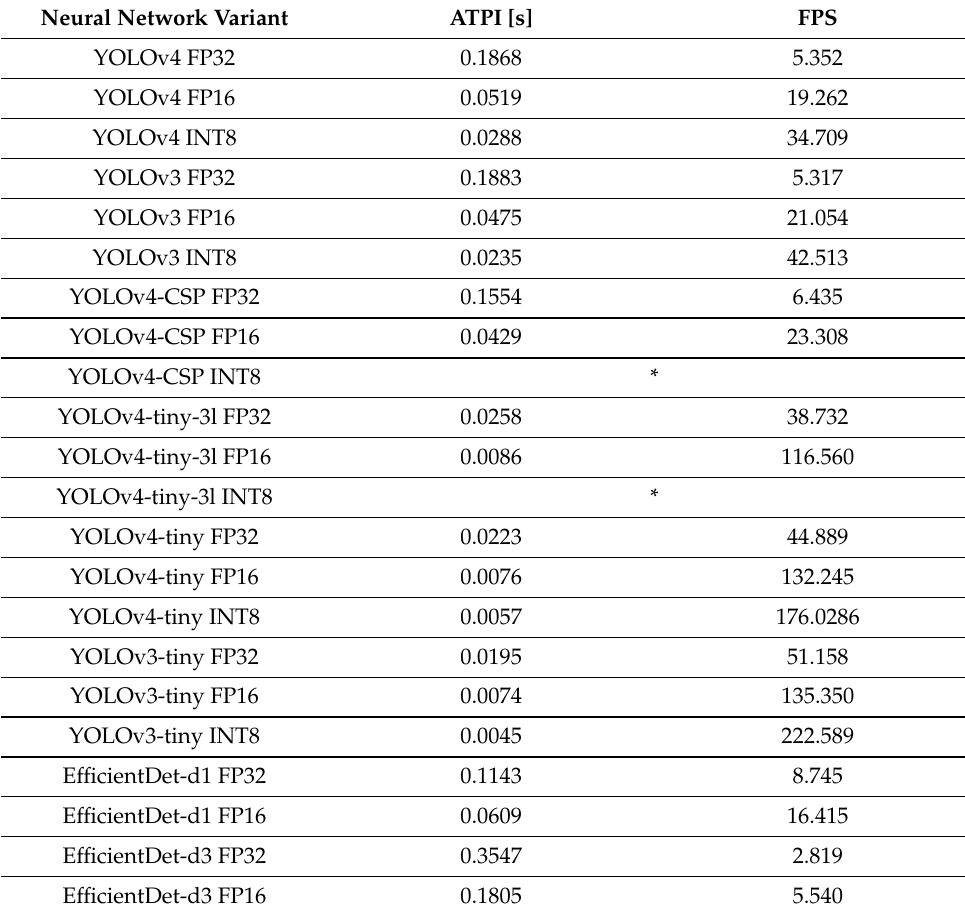
Table 3. Performance results for Nvidia Xavier NX for the tested models and their variants using a range of types for numerical representation. ATPI stands for average time per inference computed by dividing the overall batch processing time by batch size. The results for batch size yielding the maximum ATPI are displayed, as they correspond to maximum theoretical performance. Performance terms of images processed per second is also given. The asterisk (*) means that the model could not be compiled for the computational